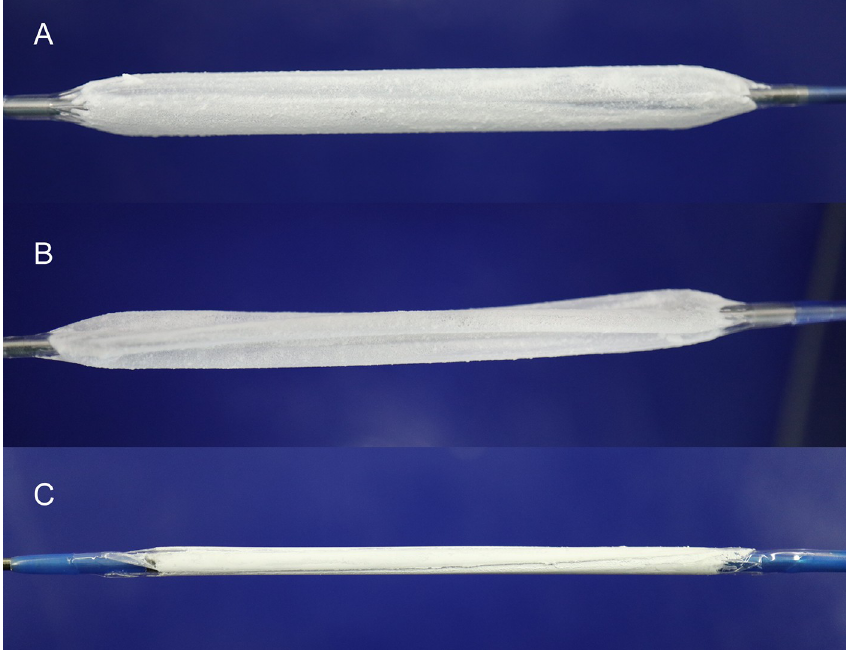
Fig 1. Conventional angioplasty balloon catheters coated with a novel, modified iopromide based matrix. Drug dose: 6 μ g Paclitaxel/mm 2 balloon surface. Balloon size: 5.0 x 40 mm. (A) inflated, (B) partly inflated with three folds, and (C)